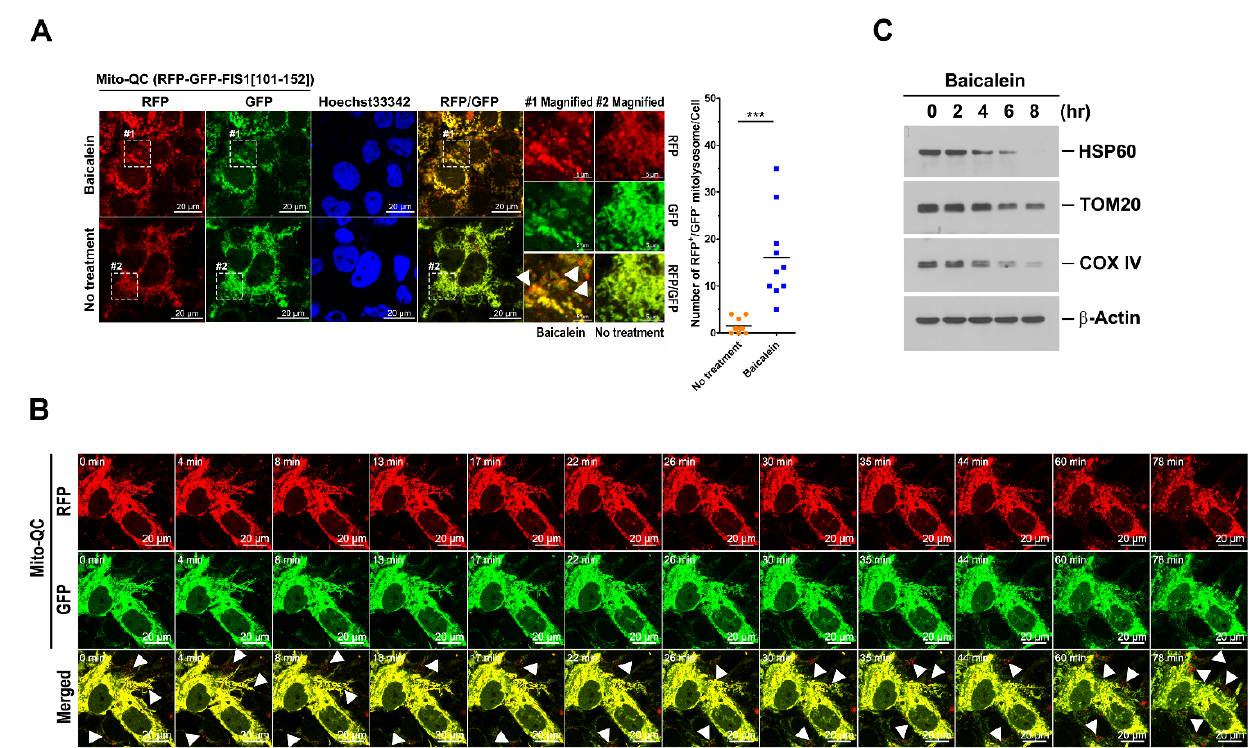
Figure 7. Mitophagic degradation induced by baicalein: (A) Huh7 cells stably expressing Mito-QC (Huh7/Mito-QC) were established by lentiviral gene delivery as described in “Materials and Methods”. The cells were treated with or without 0.5 mM baicalein for four hours, fixed, stained with Hoechst 33342, and analyzed by confocal microscopy. The white arrowheads in magnified field-1 indicate RFP + /GFP − mitolysosomes. The number of RFP + /GFP − mitolysosomes shown was quantified. The data represent the mean ± SEM ( n = 10, *** p < 0.001). Magnified field-1 and magnified field-2 show the enlarged images of the areas in white dashed boxes 1 and 2 in the images of baicalein-treated and untreated cells, respectively. ( B ) Selected live imaging frames showing 0.5 mM baicalein-treated Huh7/Mito-QC cells (Supplemental Video S7). The white arrowheads indicate the formation of RFP + /GFP − mitolysosomes. ( C ) Huh7 cells were treated with 0.5 mM baicalein and harvested at different times for use in the Western blot analysis.